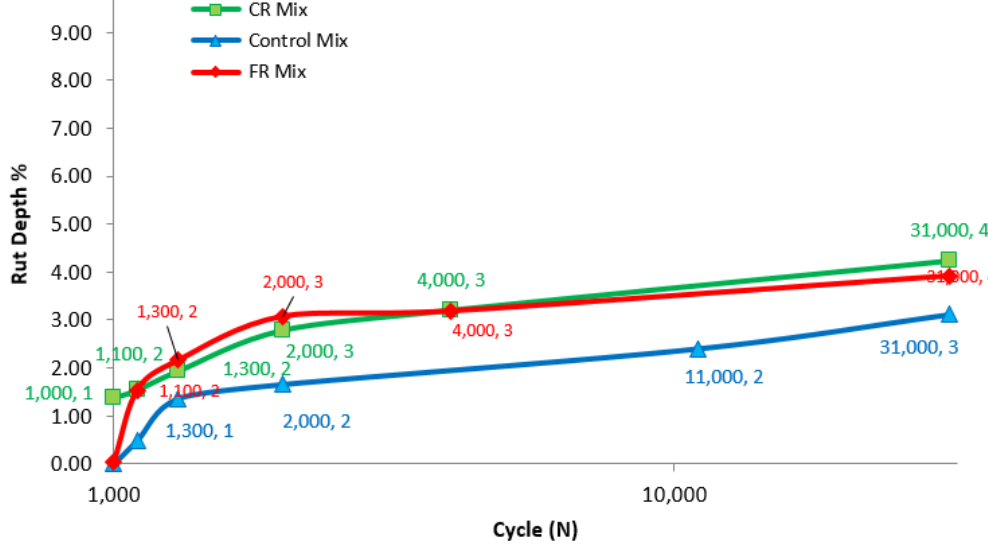
Figure 13. Permanent deformation result.